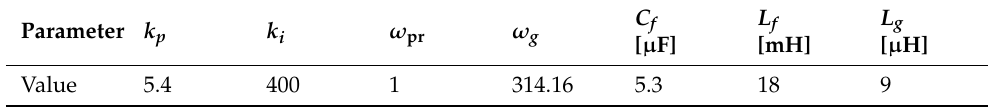
Table 1. Controller and filter parameter values of the grid-tied inverter that is investigated. Parameter k